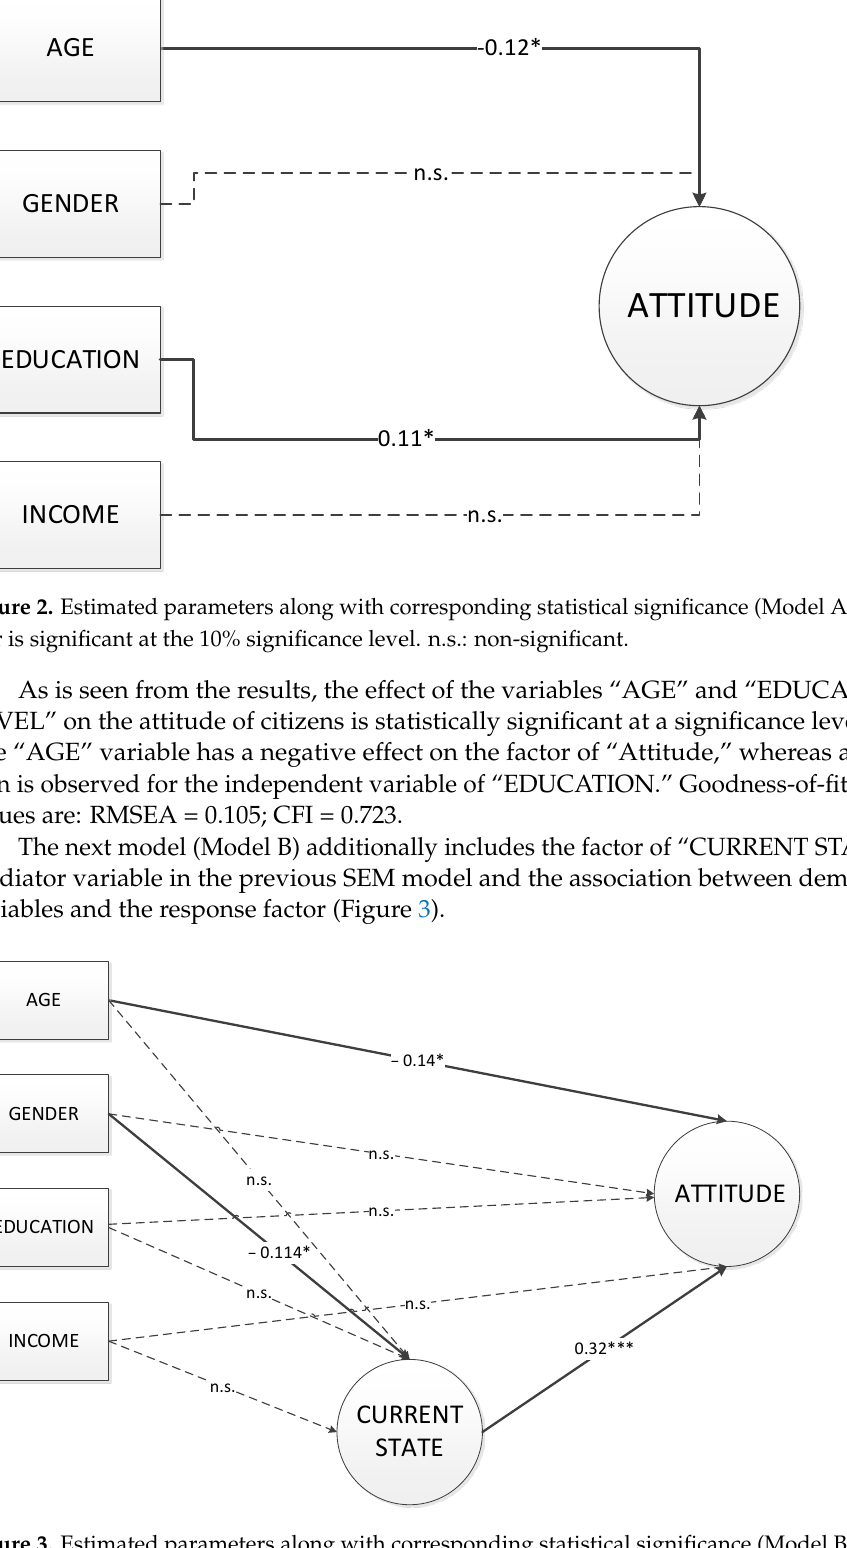
Figure 3. Estimated parameters along with corresponding statistical significance (Model B). * parameter is significant at the 10% significance level. *** parameter is significant at the 1% significance level. n.s.: non-significant.